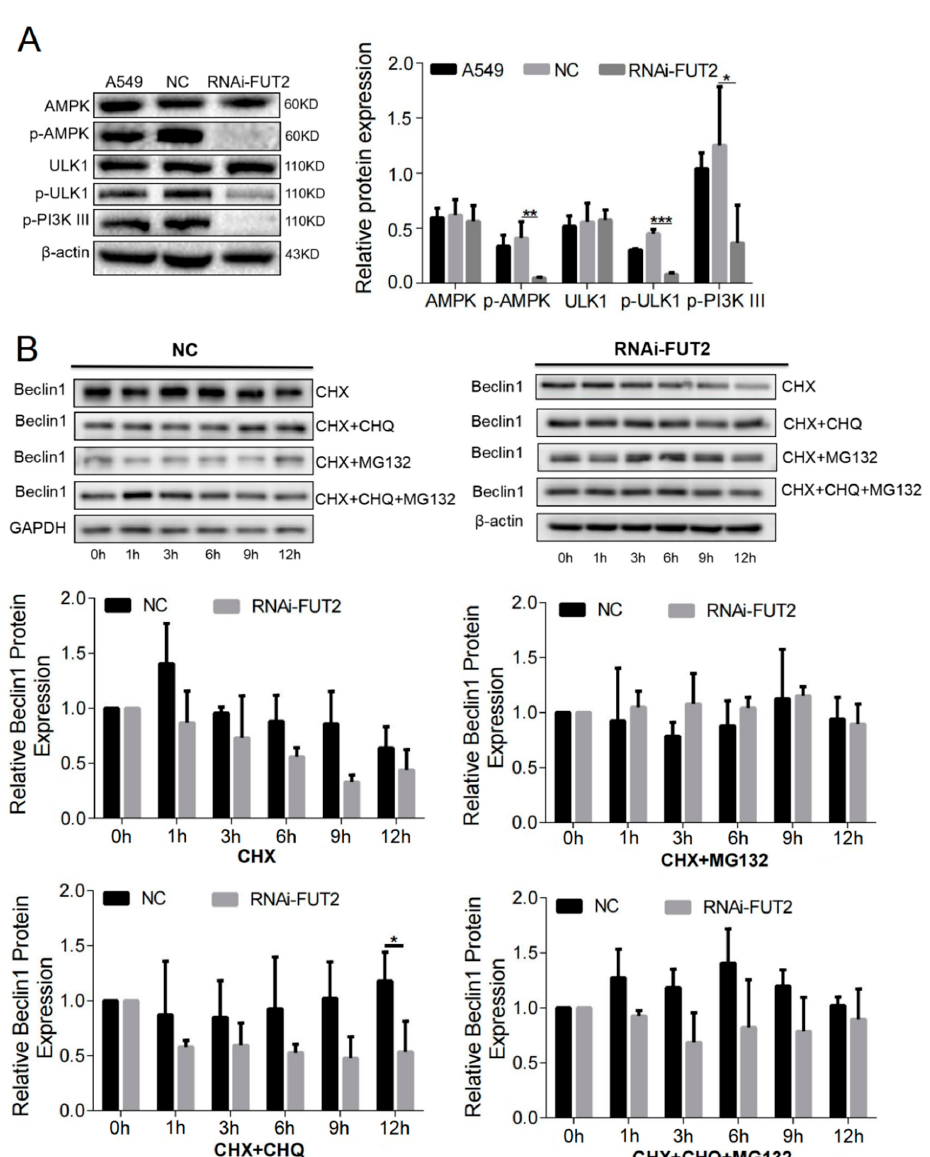
Figure 4. FUT2 promotes autophagy through the AMPK/ULK1/PI3K III pathway in A549 cells. ( A ) Representative Western blot showing that the knockdown of FUT2 reduced the levels of p-AMPK, p-ULK1, and p-PI3k III in A549 cells. ( B ) Representative Western blot showing the time course of the Beclin1 protein levels in FUT2-knockdown A549 cells or control cells according to different times in CHX, in the presence or absence of CHQ or MG132. (* p < 0.05, ** p < 0.01, and *** p < 0.001).